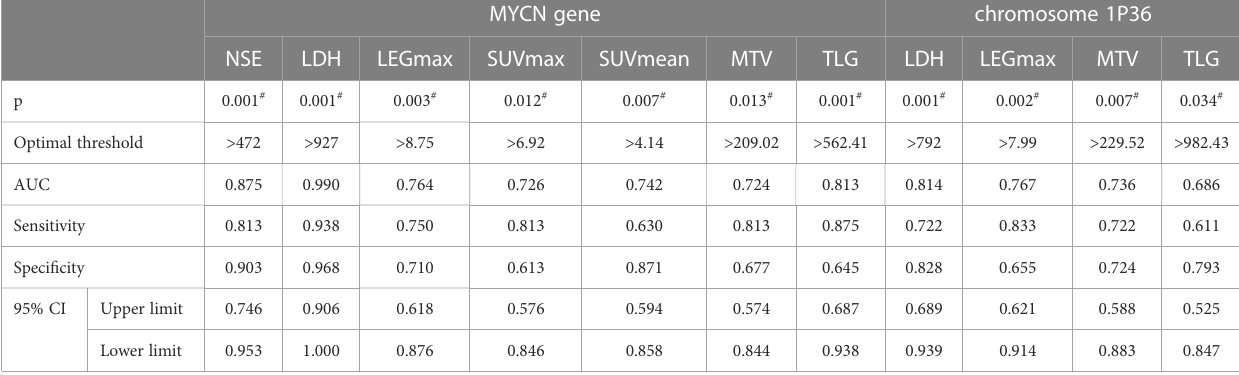
TABLE 6 Performance of ROC curves predict the MYCN gene ampli fi cation and chromosome 1p36 deletion.